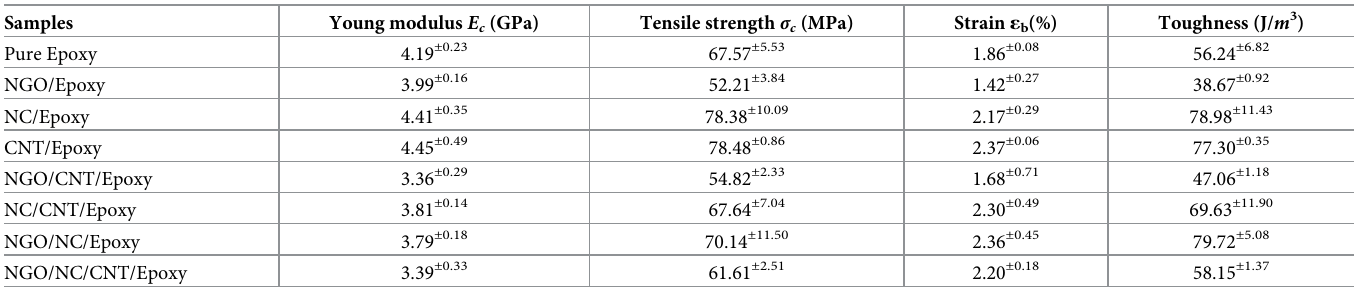
Table 2. Mechanical properties of pure epoxy and nanocomposites.